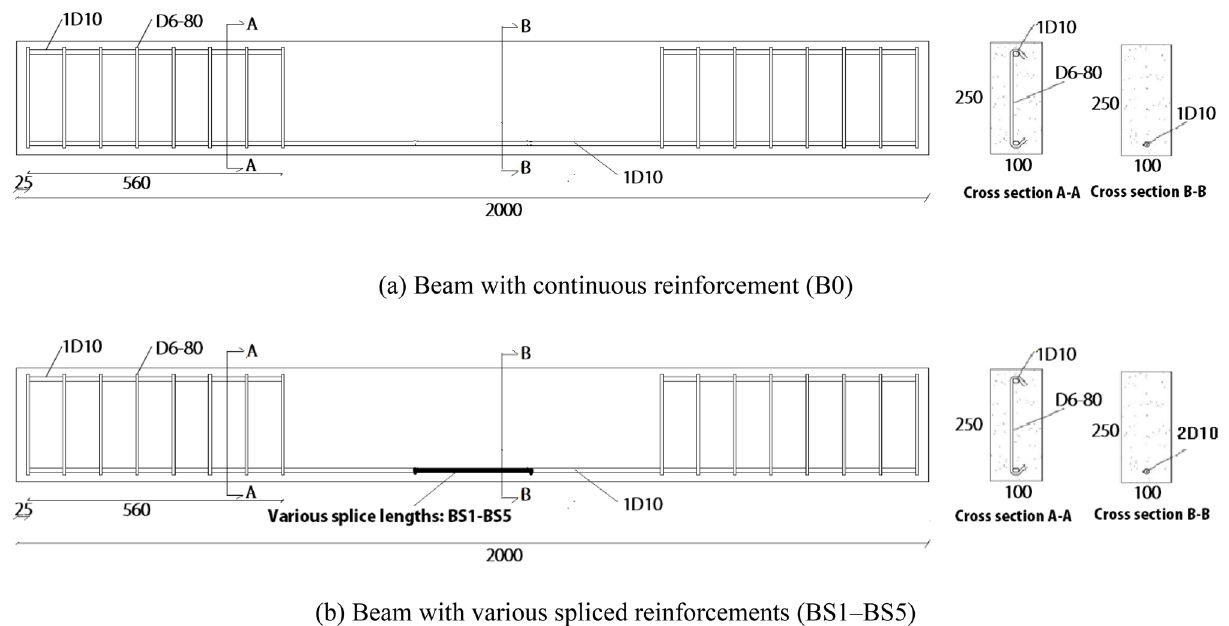
Fig. 1 Beam specimens with their reinforcements